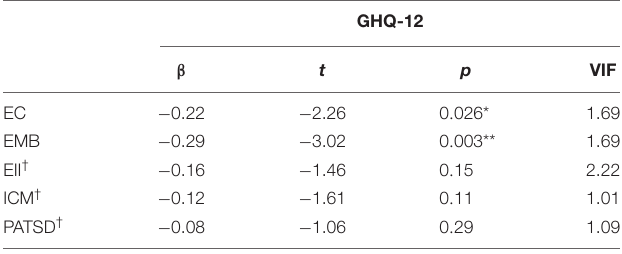
TABLE 4 | Stepwise multiple regression analysis: the scores on the four ORI subscales and the three TEIP subscales as predictors of GHQ-12.